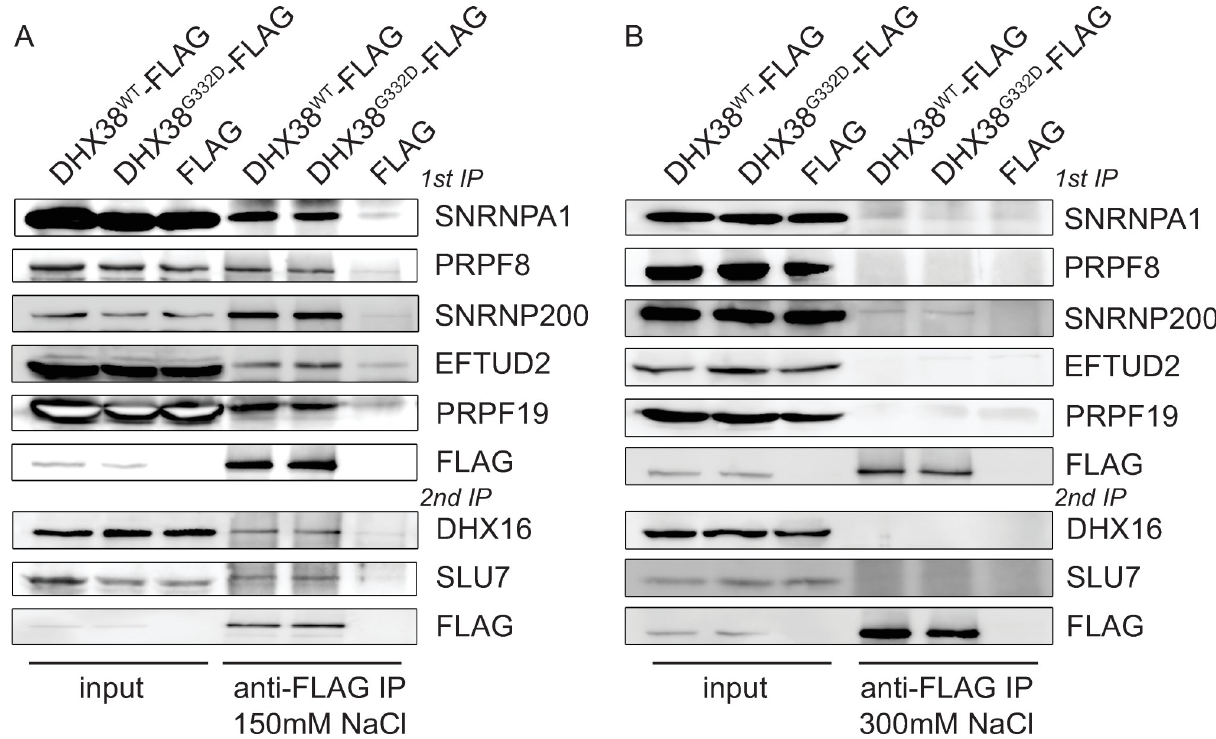
Fig 1. DHX38 associates with multiple spliceosomal components. DHX38 WT -FLAG and DHX38 G332D -FLAG were transiently expressed in HEK293 cells, immunoprecipitated and copurification of selected spliceosomal proteins monitored. Immunoprecipitation was performed in normal NET2 buffer containing 150 mM NaCl (A) or in stringent NET2 buffer containing 300 mM NaCl (B).